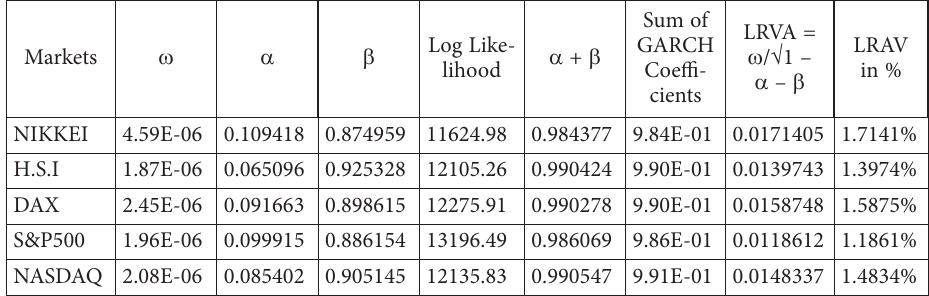
Table 8. Econometric analysis (GARCH Coefficients) for developed markets